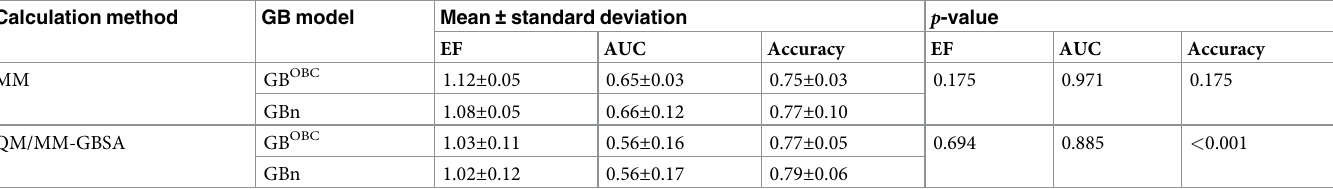
Table 3. Impact of GB (generalized Born) model on the discriminating ability of binding affinity estimation methods.